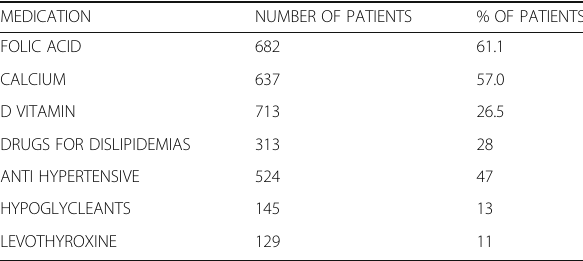
Table 1 (abstract O58). Medications used in patients with